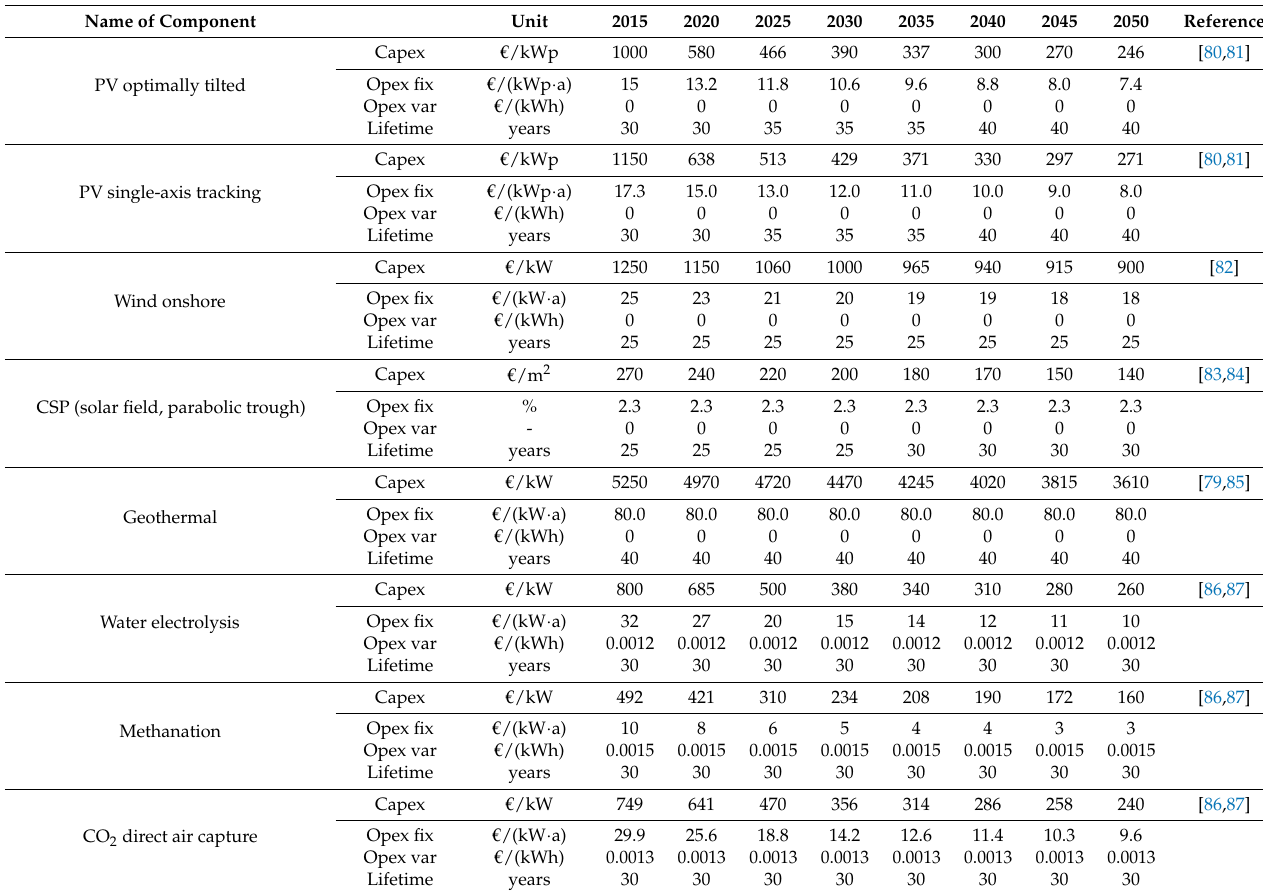
Table A1. Technical and Financial Assumptions of all energy system components used in the energy transition from 2015 to 2050 for KSA. Assumptions are taken from Pleßmann et al. [78] and European Commission [79] and further references are individually